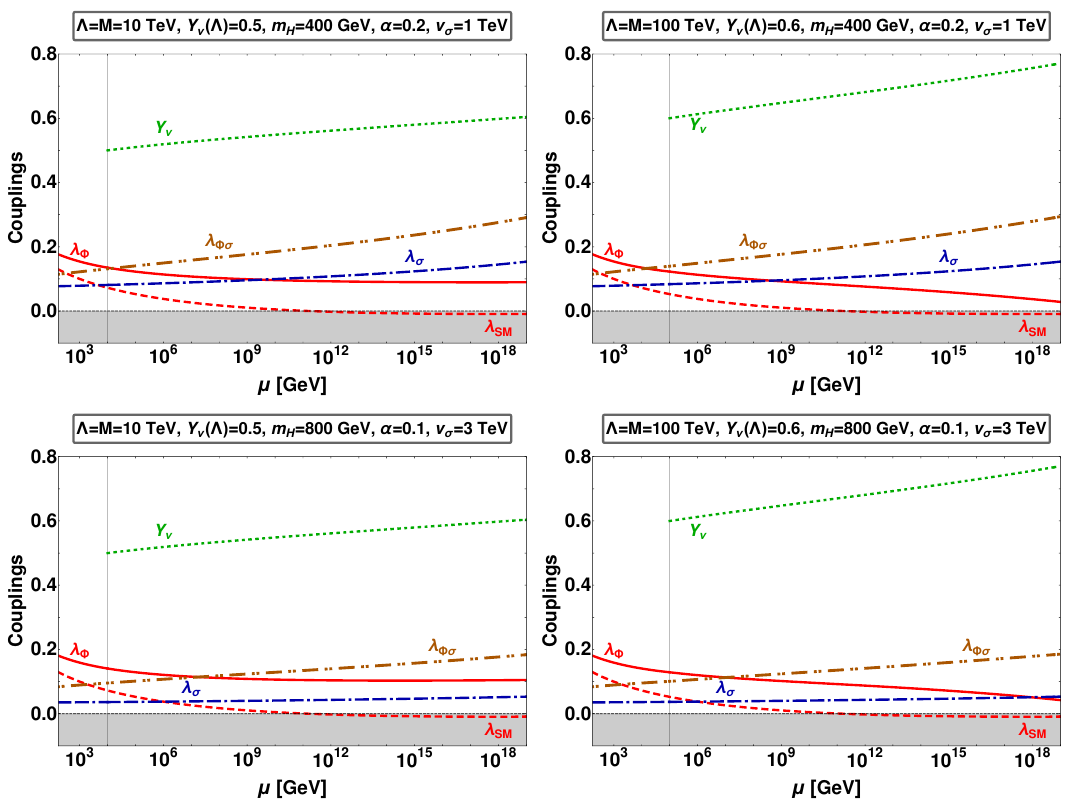
Figure 9 . Evolution of the quartic couplings and right-handed neutrino Yukawas within the Majoron extension of the missing partner (3,1,1) inverse seesaw scheme. For comparison, the evolution of λ SM is shown in the red dashed curve. Here only the fermion singlets are integrated out at the threshold scale Λ = M , all scalars are part of the effective theory below threshold, taken as the weak